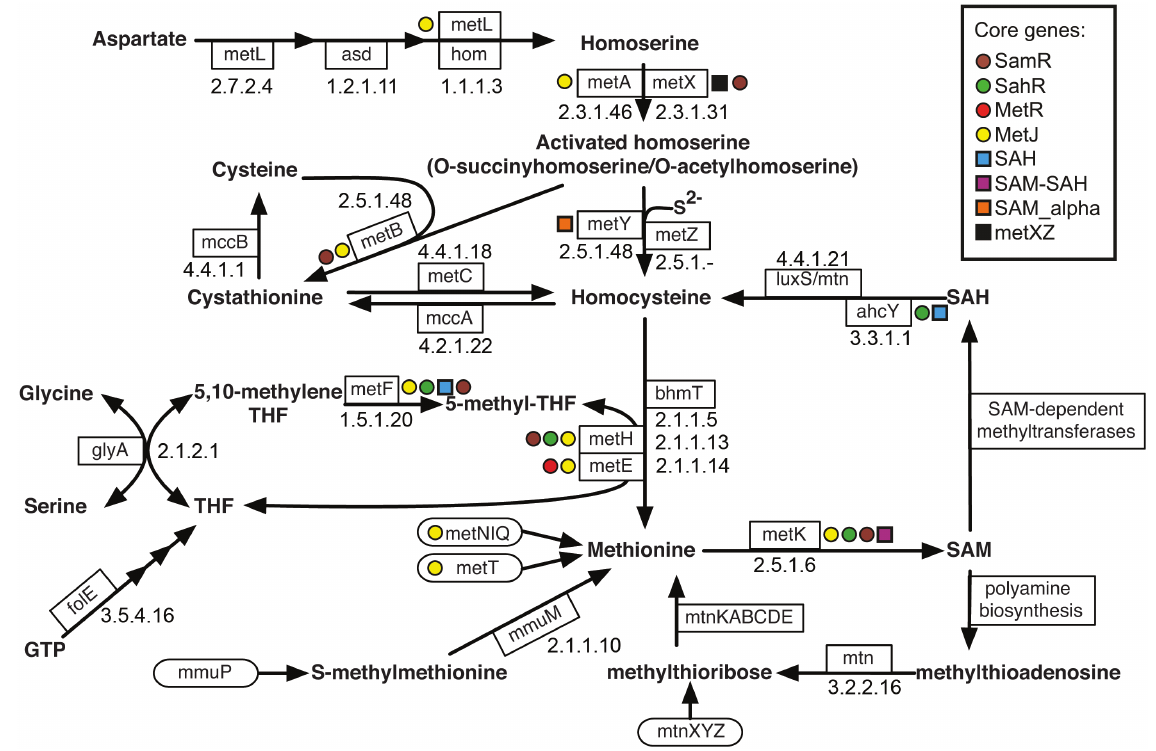
Figure 1. Methionine metabolism and its conserved regulation in Proteobacteria. Genes encoding enzymes for respective reactions are shown in boxes. The Enzyme Commission numbers (EC numbers) of these reactions are shown. Genes encoding transporters of methionine, methylmethionine, and methylthioribose are shown in rounded boxes. Alternative isoenzymes or transporters are shown in different boxes attached to the same arrow. Core regulon members for TFs and riboswitches are shown by colored circles and squares, respectively. The taxonomic distributions of these regulatory interactions are shown in Figure 7.